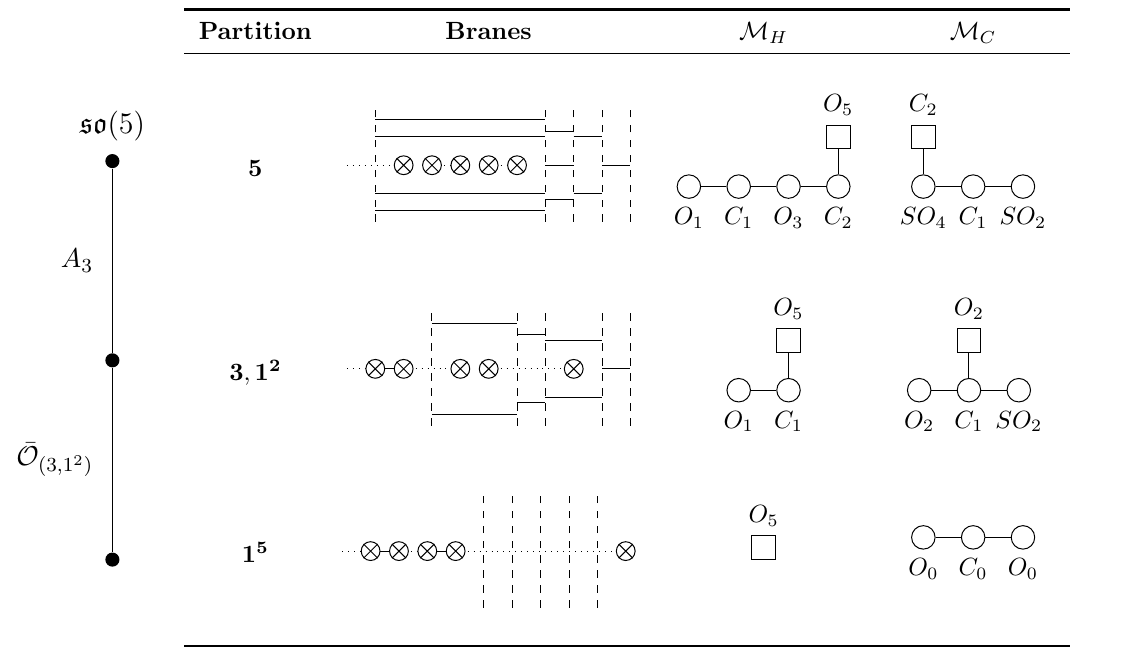
Table 4. Summary of Kraft-Procesi transitions for the nilpotent orbits of so (5). The brane systems in the middle depict models whose Higgs branch is the closure of the nilpotent orbit labelled by each Partition . The column M H contains the quivers of such models, with M H = (cid:22) O (cid:21) . The column M C depicts the quivers of the models obtained after performing S-duality transformation on the Brane systems, they have M C = (cid:22) O (cid:21) . The C 0 and O 0 gauge nodes have been left in this column to highlight the e(cid:11)ect that the transition has on these quivers: the (cid:13)avor nodes move along a (cid:12)xed structure of gauge nodes, while the rank of the gauge nodes